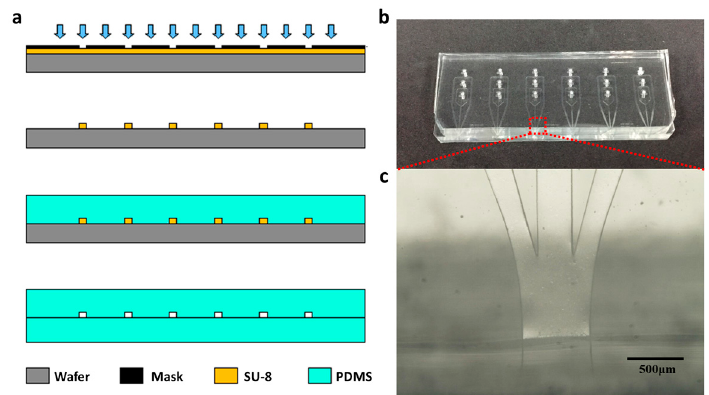
Figure 2. ( a ) Schematic for soft lithographic fabrication sequence; ( b ) Photo for microfluidic device with an array of microchannels which can be used individually; ( c ) The enlarged microscope image for the jetting nozzle corresponding to part in the red dotted rectangle in ( b ).